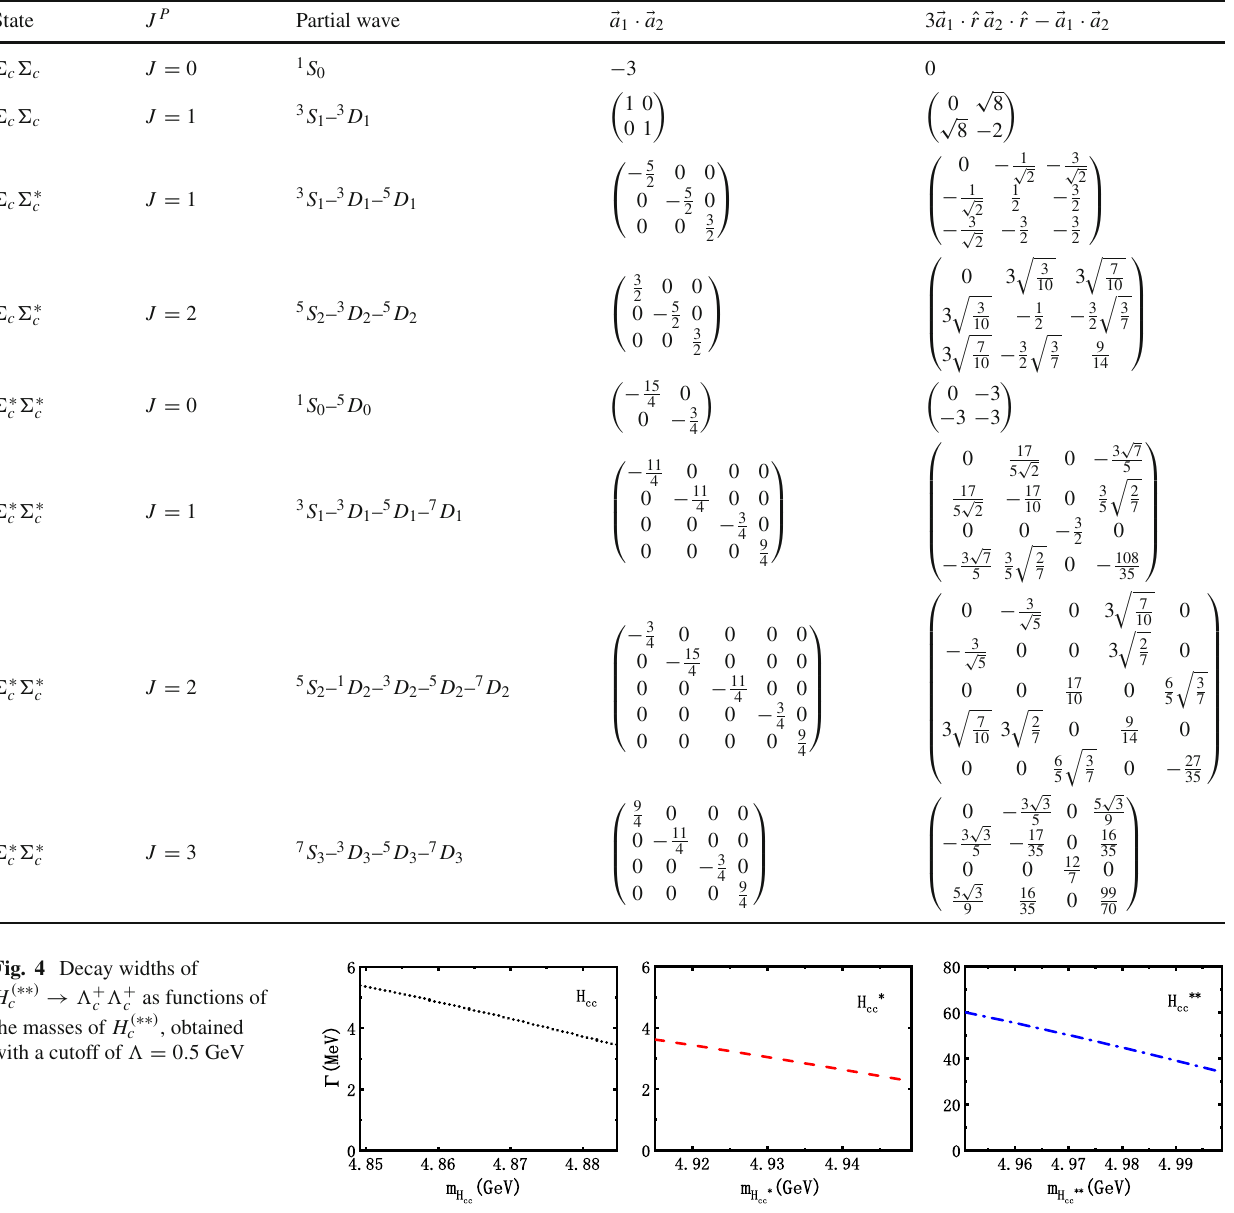
Fig. 4 Decay widths